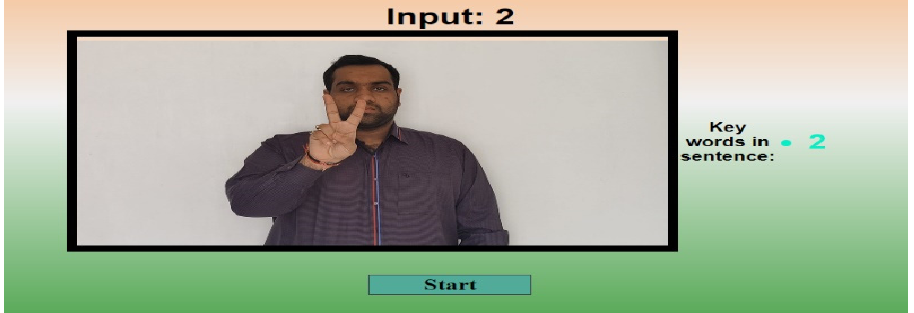
Figure 16. Case 7. Available video for number ‘2’.